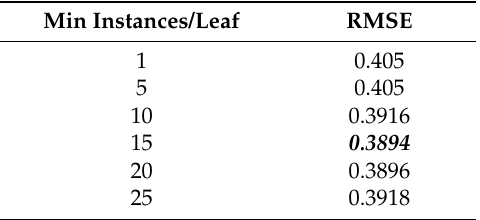
Table A3. Sensitivity of M5 model trees (M5P) to the minimum number of instances per